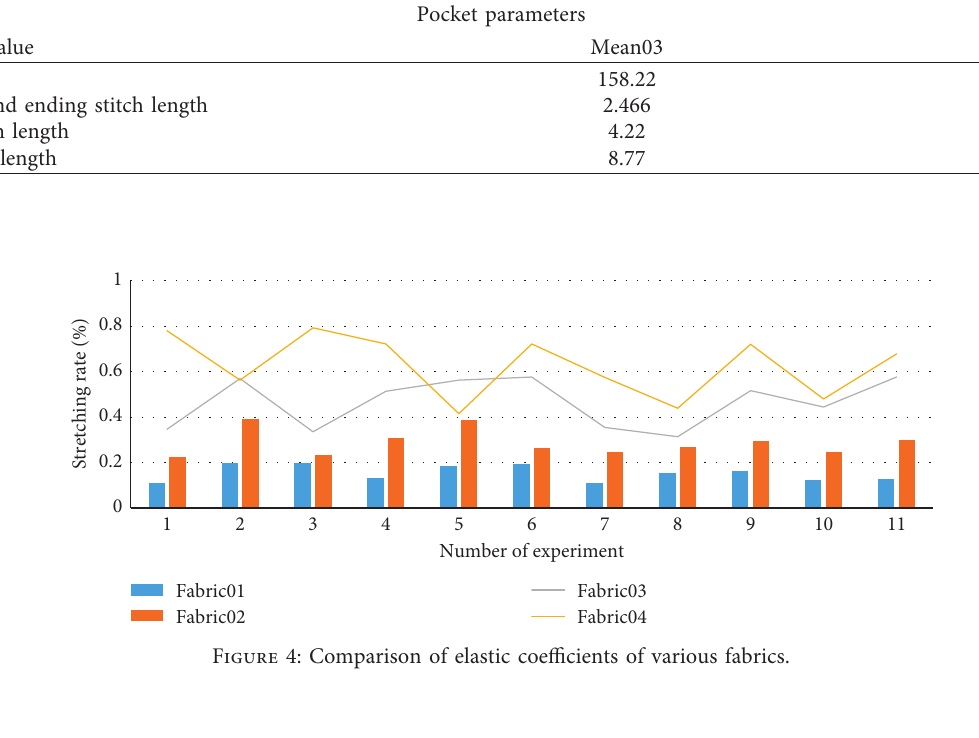
Table 5: 03 and 04 fabric experimental average.